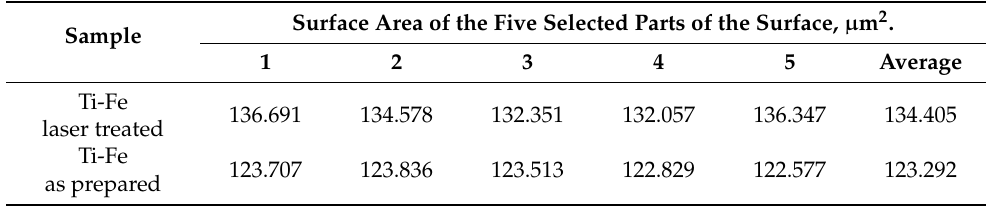
Table 2. Values of the surface area obtained by AFM respect to a projection area of 95.36 µ m 2 . Surface Area of the Five Selected Parts of the Surface, µ m 2 . Sample